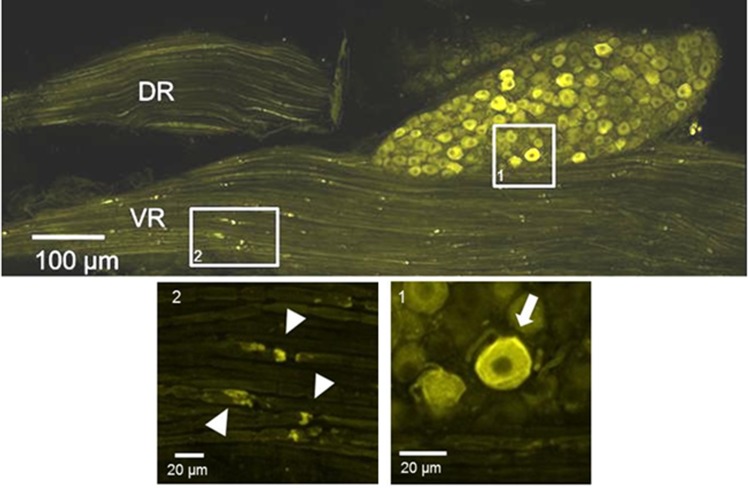
Anatomical expression ChR2/YFP.Image of a whole mount of the L4 dorsal root ganglion, dorsal root, and ventral root from a Thy1-ChR2/YFP mouse. Note that a subset of axons in the ventral root (VR) and dorsal root (DR) are ChR2+ as indicated by the presence of YFP in the axons. The insets are a higher magnification of the image marked with a white box. Inset 1: Strong YFP expression was observed in the cell bodies of primary sensory neurons. Inset 2: Small, punctate regions were observed along the motor axons.